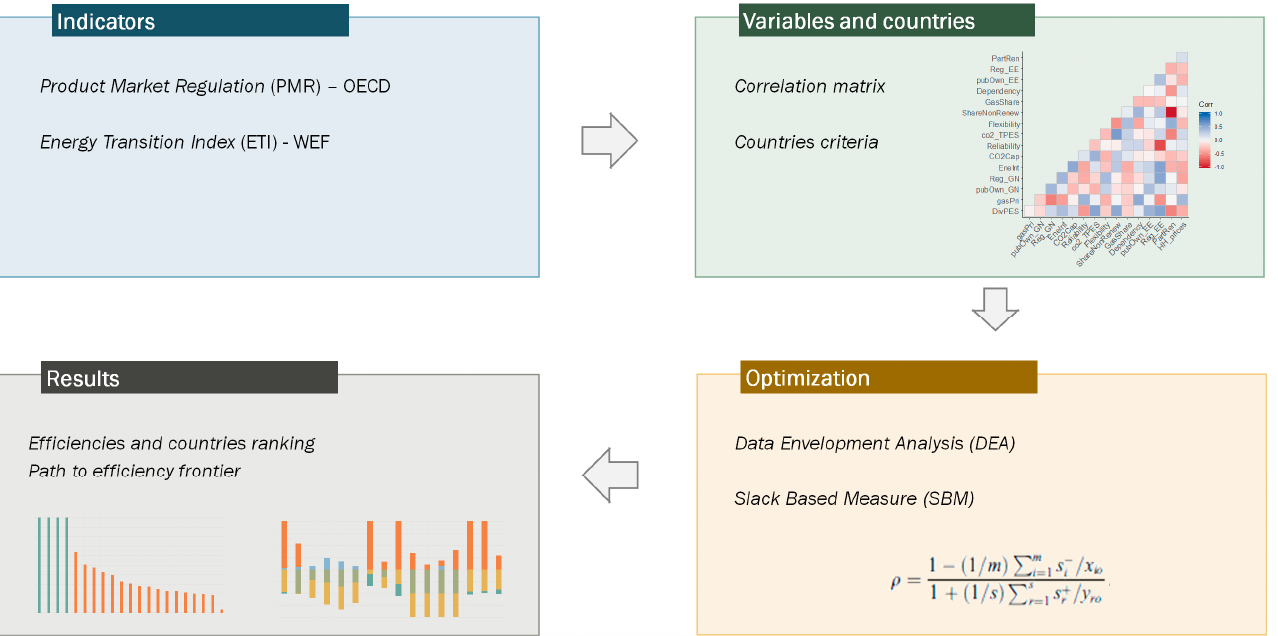
Figure 1. Methodology. Source: The authors .